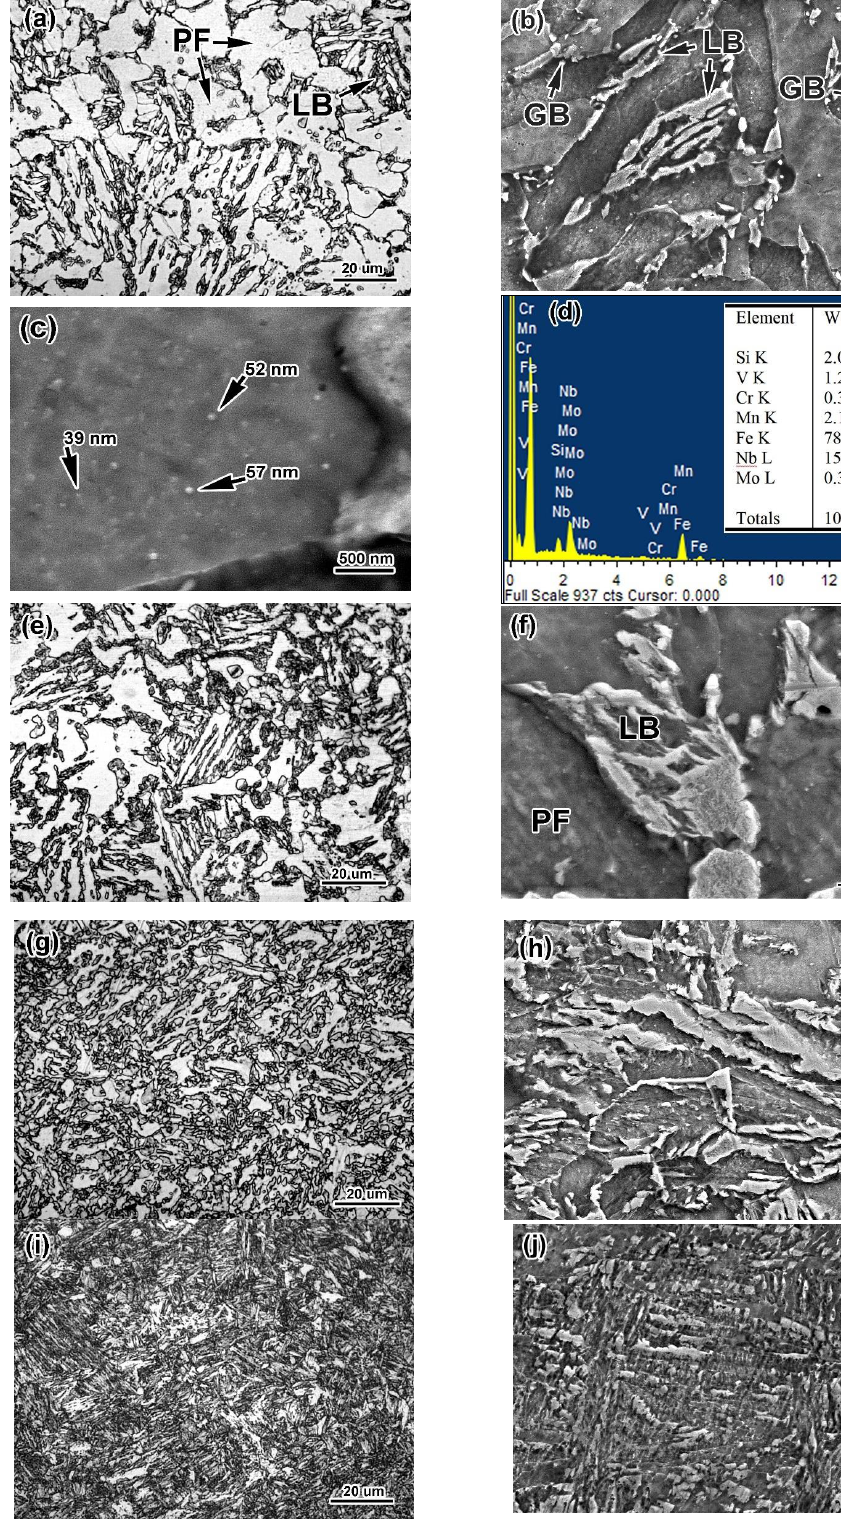
Figure 5. Microstructure of the specimens austenitized at different temperatures: ( a – c ) 770 °C, ( d ) EDX-spectrum of a carbide precipitate, ( e , f ) 830 °C, ( g , h ) 900 °C, and ( i , j ) 950 °C (( a , e , g , i ) — OM images; ( b – d , f , h , j ) — SEM images; F — proeutectoid ferrite, LB — lamellar bainite, and GB — granular bainite). A reduction in the volume fraction of proeutectoid ferrite was observed with a cor- responding increase in the bainite amount (Figure 5e,f) as the austenitizing temperature was increased to 830 °C. The volume fraction of proeutectoid ferrite reduced drastically at T A =900 °C, and the structure primarily consisted of bainite (Figure 5g) while bainitic laths became shorter (fragmented) and less oriented (Figure 5h). The austenitization in the austenite domain (T A =950 °C) resulted in the elimination of a proeutectoid ferrite, and the entire structure consisted of bunches of short parallel (partially fragmented) bainitic plates, as shown in Figure 5i,k. Figure 6a shows the XRD patterns of the austempered specimens. Each austenitiza- tion temperature was characterized by a similar XRD pattern containing the high peaks of -Fe (bcc) and low peaks of -Fe (fcc). The austenitization at 770 °C (Figure 6b) is in- dicated by the lowest values of the volume fraction of retained austenite (2.48 vol.%) and carbon content in RA (0.82 wt.%). With a austenitization temperature increase to 900 °C, the RA volume fraction gradually increased to 8.65 vol.%. As T A increased to 950 °C, the RA volume fraction decreased to 5.45 vol.%, which was still twice as high as at T A =770 °C. At T A =830 – 950 °C, the carbon content in RA reached 1.18 – 1.24 wt.%, which is 1.4 – 1.5 times higher than that at 770 °C.